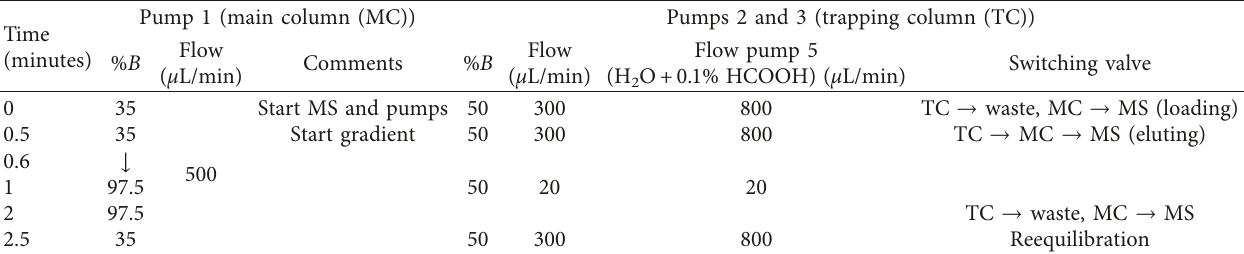
Table 1: Settings of the HPLC